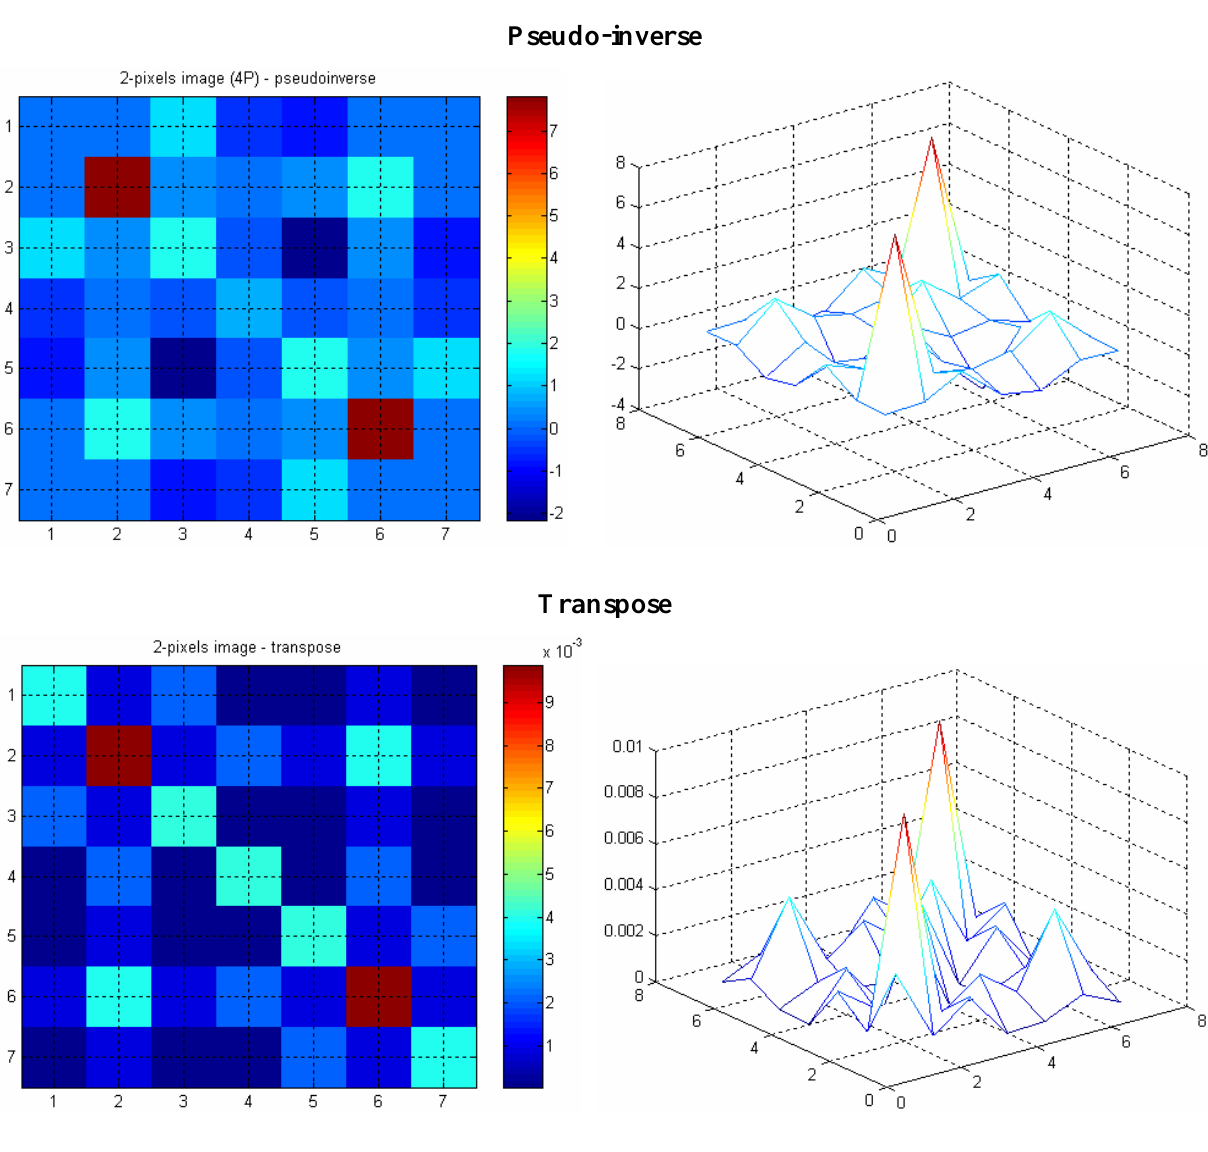
Figure 13. Two-particles image with four